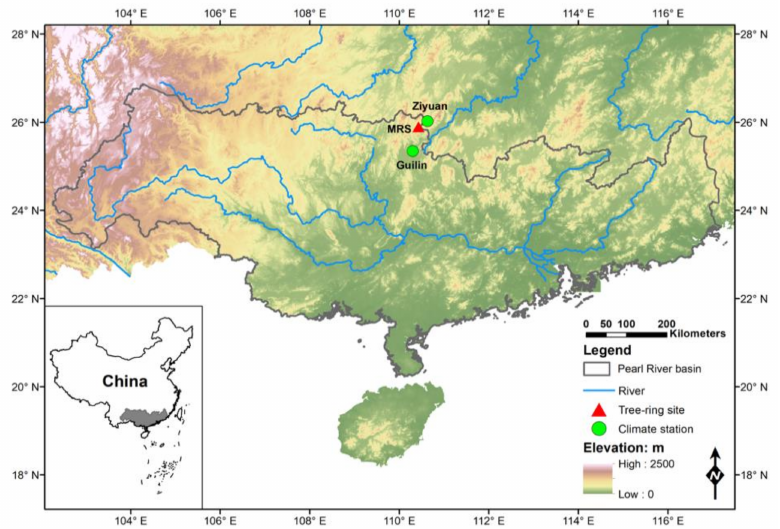
Figure 1. Map of the Pearl River basin showing the location of the tree-ring sampling site (red triangle) and two nearby meteorological stations (green